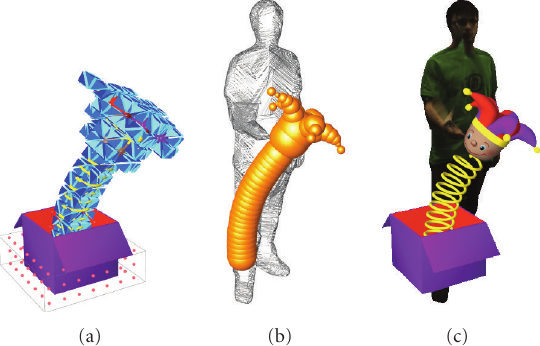
Figure 7: An interactive deformable object, (a) collides with the 3D-reconstructed mesh, (b) allowing interactions with the user in